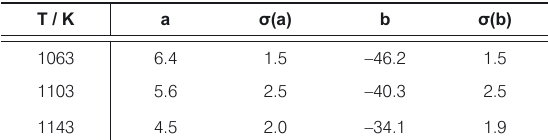
Figure 4. Enthalpy of mixing of melt in the system KF–K TaF . 2 7 H) values. bars are σ ( Δ mix Table 2. Regression coefficients and their standard deviations for Eq. 5.